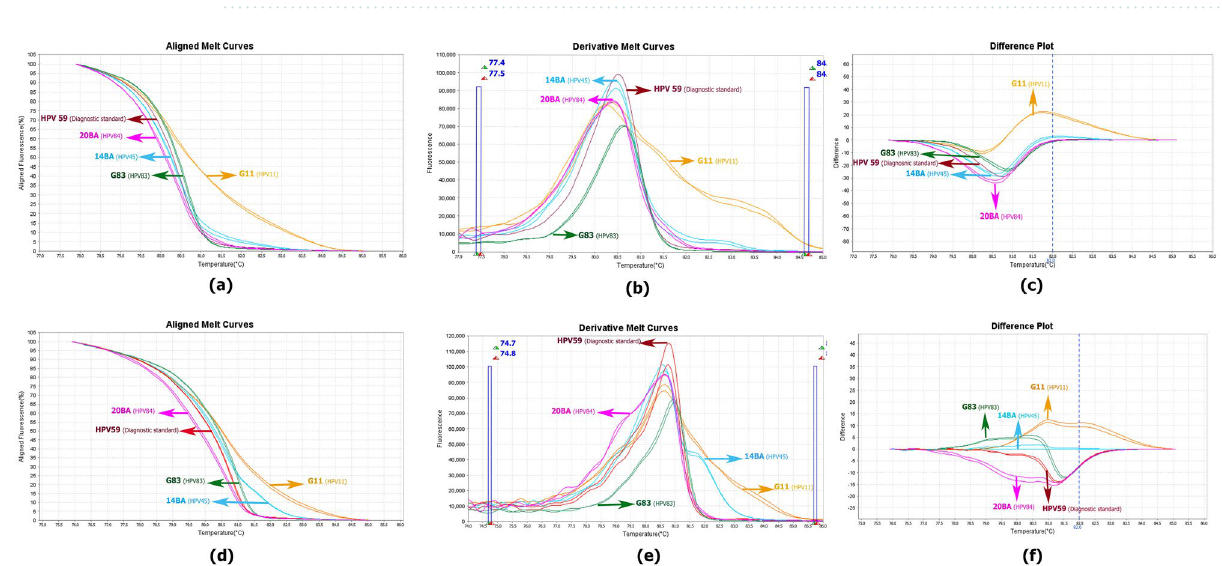
Figure 4. Aligned melt curves, derivative melt curve, and difference receptivity in approach one related to HPV 59 (diagnostic standard) and DNA HPV identified by the microarray method ( a , b , c ) Aligned melt curves, derivative melt curve, and difference receptivity in approach two related to HPV 59 (diagnostic standard) and DNA HPV identified by the microarray method ( d , e , f